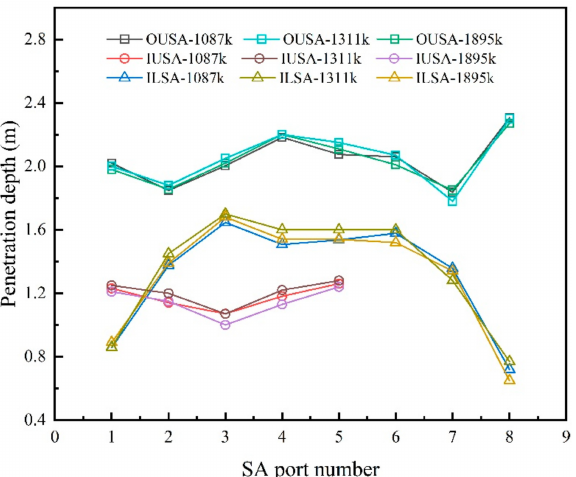
Figure 6. Penetration depth of SA at 100%BMCR uniform case with various grid quantity.